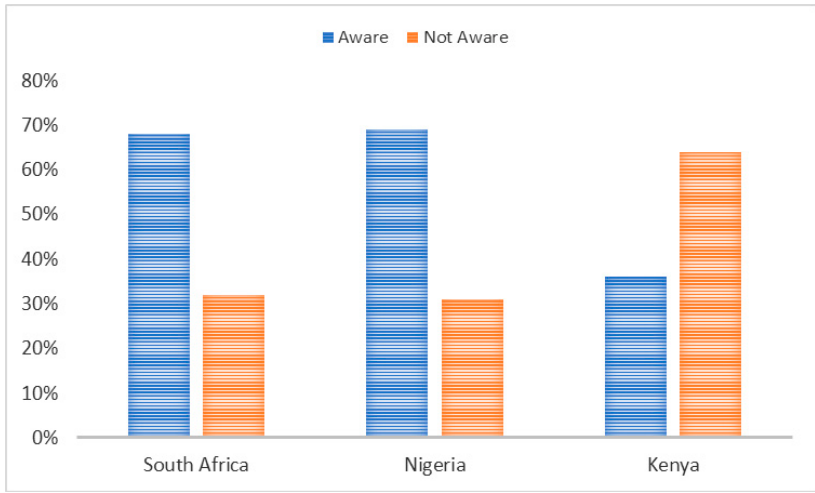
Figure 7. Level of Awareness among participants. Source: [42].